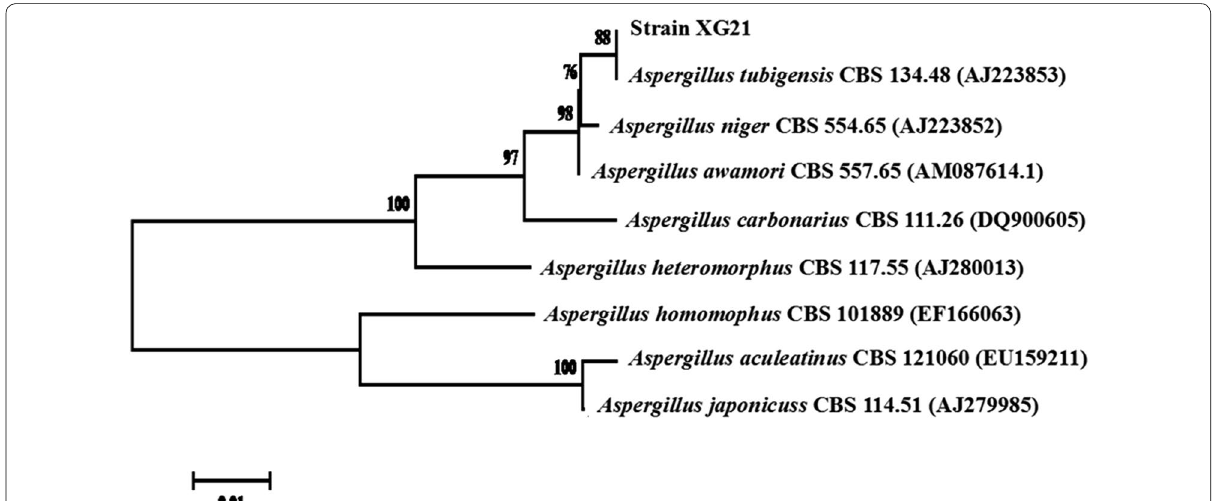
Fig. 2 Phylogenetic tree showing the position of the strain XG21 based on the internal transcribed spacer (ITS) sequence of nuclear ribosomal DNA. The number at the branch nodes indicates bootstrap values (%) based on 1000 replications. The scale bar denotes 0.01 changes per nucleotide